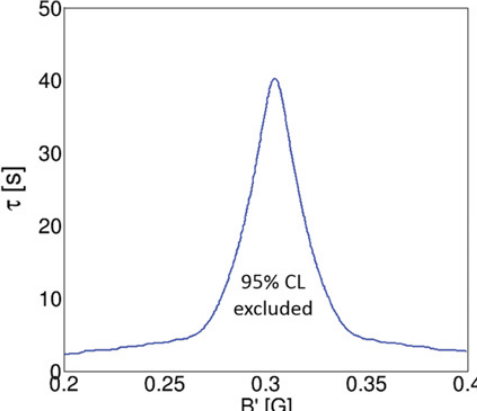
Figure 2. Sensitivity of the characteristic oscillation time vs. mirror magnetic field after one week regeneration experiment at GP-SANS with an applied magnetic field of